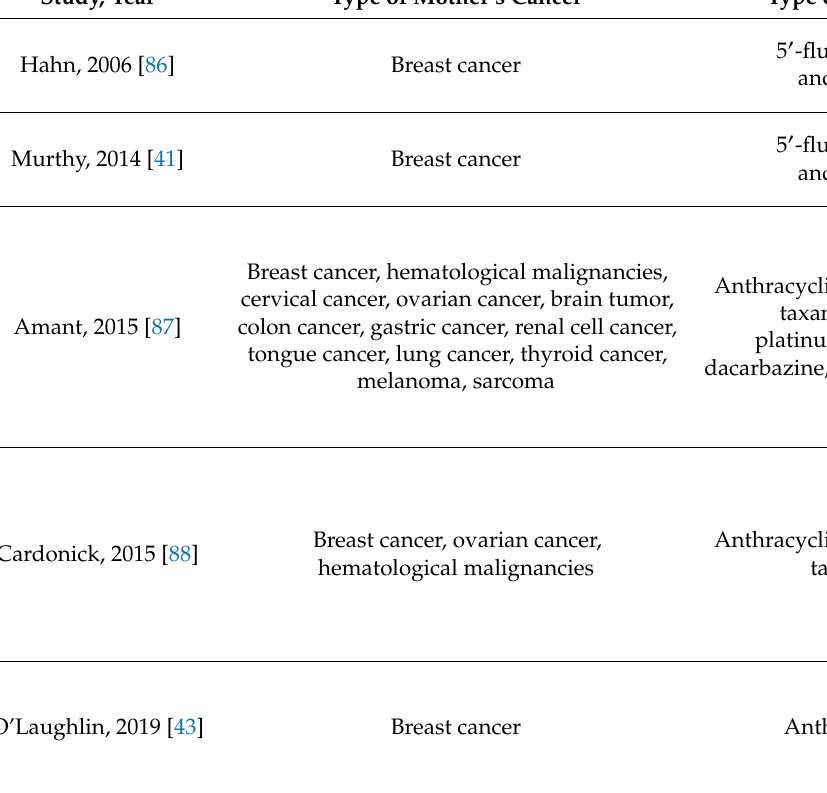
Table 2. Main results of the studies reporting short- and long-term outcomes following in utero exposure to chemotherapy. Study,